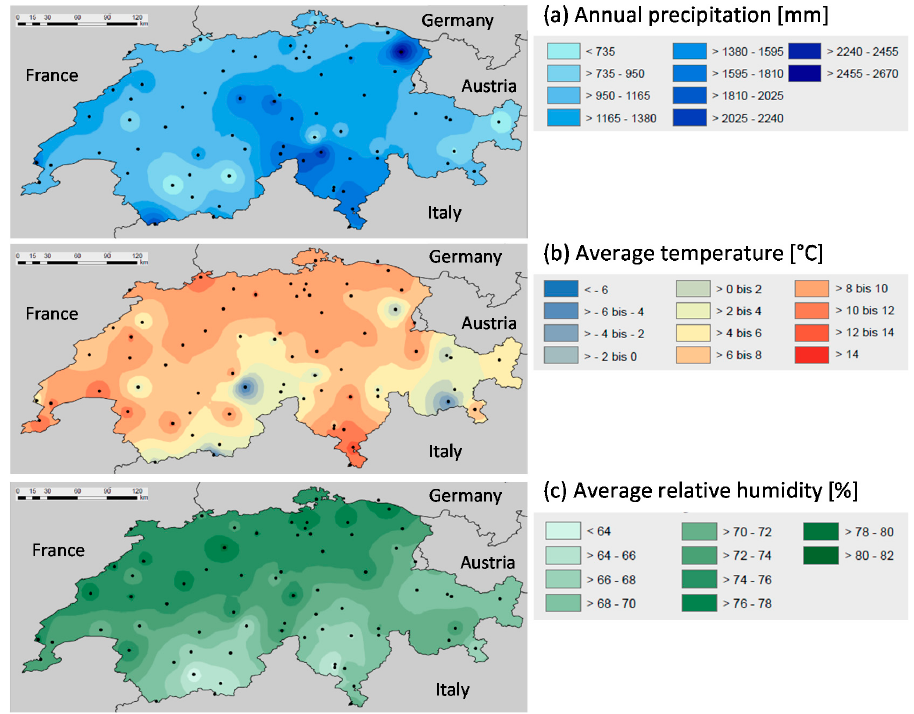
Figure 2. Climatic characteristics of Switzerland. ( a ): Annual precipitation. ( b ): Annual average temperature. ( c ): Average relative humidity.